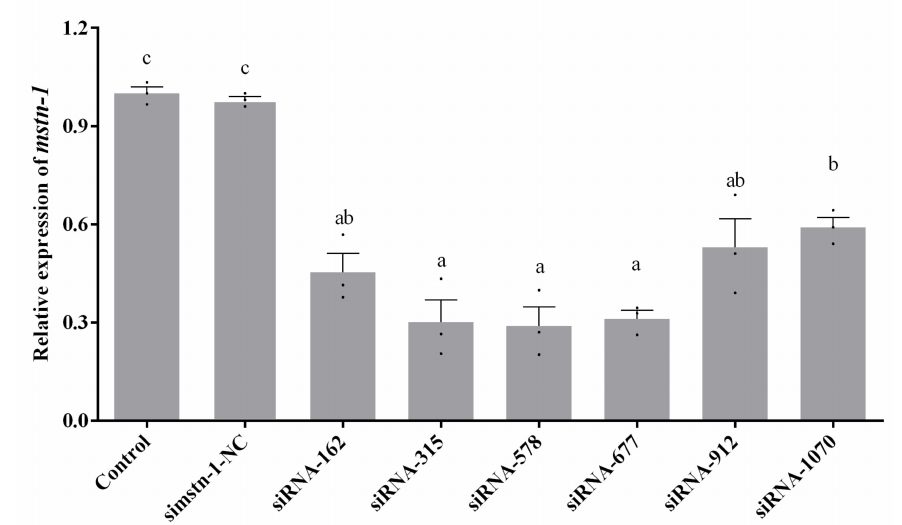
Figure 3. Relative level of mstn-1 mRNA in primary cultured muscle cells treated with si mstn-1 . Results are represented as mean ± SE ( n = 3). Values with di ff erent letters mean significant di ff erences ( p < 0.05). Letter a and c represent the lowest value and the highest value respectively. Letter b represents the value significantly higher than a but significantly lower than c . Letter ab represents the value significantly lower than c but has no significant di ff erence with a and b